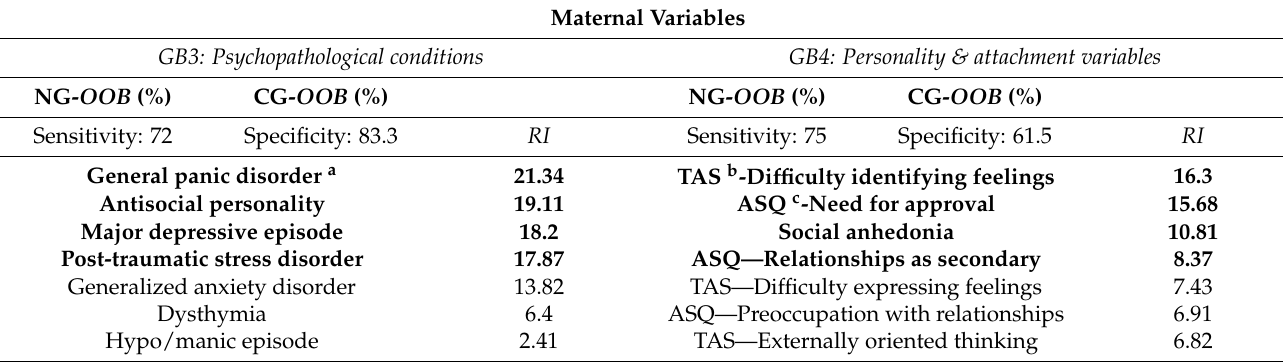
Table 3. Gradient boosting analyses estimated on the two sets of maternal variables showing good “out of bag” ( OOB ) sensitivity and specificity, and the relative importance (RI) of the variables for the distinction of the neglected group (NG) and the non-neglected control group